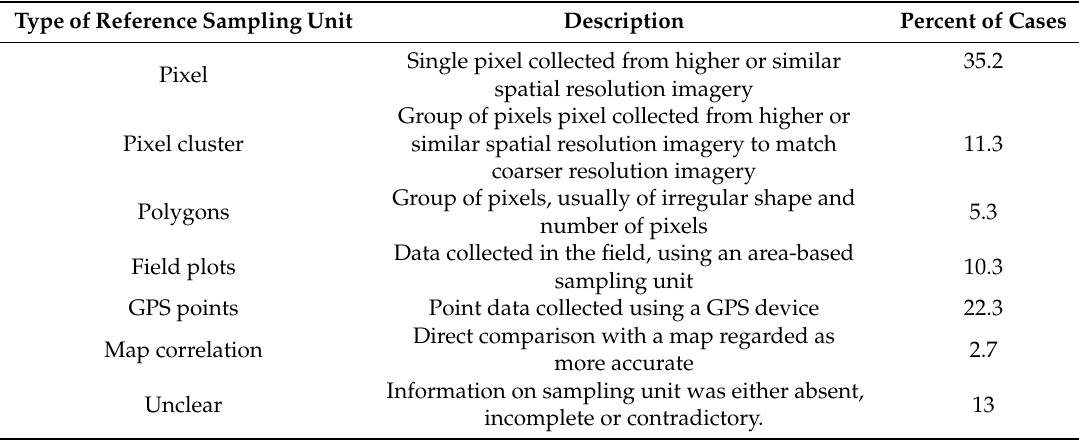
Table 1. Percent of cases for each type of sampling validation unit.